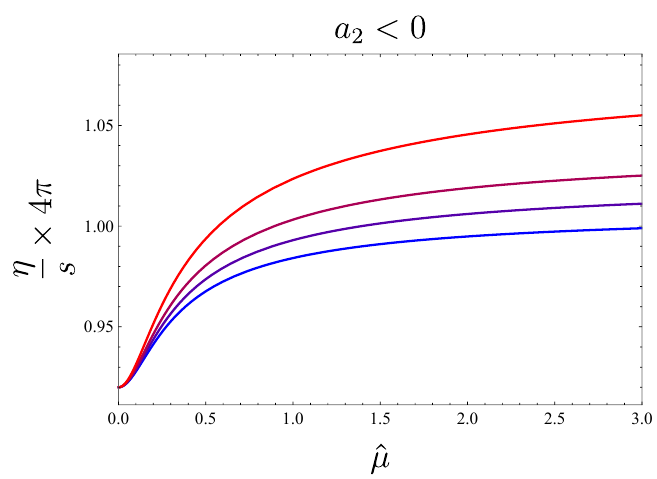
Figure 6. Shear viscosity over entropy density as a function of the chemical potential in the case in which a 0 . We take λ = 0 . 02 , and from blue to red, the different curves correspond to { α 2 < { 0 . 0024 , − 0 . 016 , 0 . 082 } , { 0 . 0019 , − 0 . 012 , 0 . 080 } , { 0 . 0006 , − 0 . 0023 , 0 . 077 } , { 0 , 0 . 0038 , 0 . 083 } , which satisfy all the physical constraints. As a general rule, η/s is a growing function of ˆ µ and its value does not depart much from 1 / (4 π )